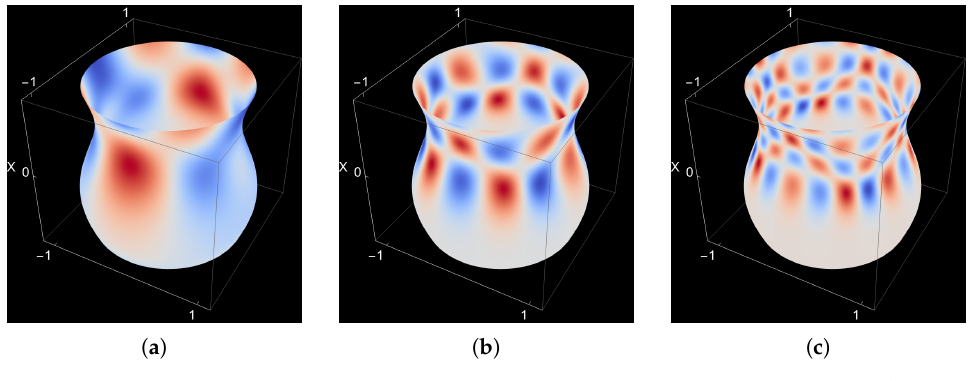
Figure 8. Case EH: ( a ) t = 10 − 2 . Range w ∈ [ − 0.979054,0.934767 ] . ( b ) t = 10 − 4 . Range w ∈ [ − 450.092,404.416 ] . ( c ) t = 10 − 6 . Range w ∈ [ − 19,710.5,18,415.5 ] .